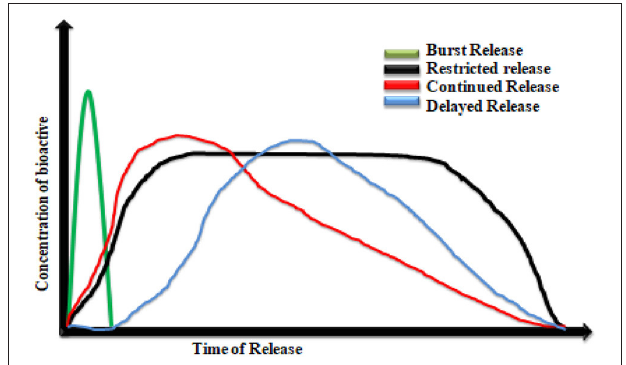
FIGURE 3 | Various release profiles plotted with time on x -axis and respective concentration of bioactives at y -axis (Adapted from Boostani and Jafari,